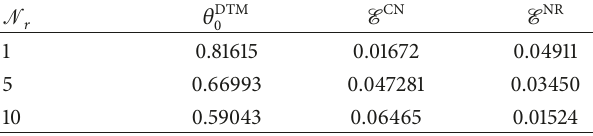
Table 7: Numerical solutions obtained for DTM and the maxi- mum error computed between the respective numerical solutions obtained, where E CN = max | CN sol − DTM sol | and E NR = max | CN NR sol − DTM sol | , and their respective temperatures at the tip of the fin for varied values of N 𝑐 . N 𝑟